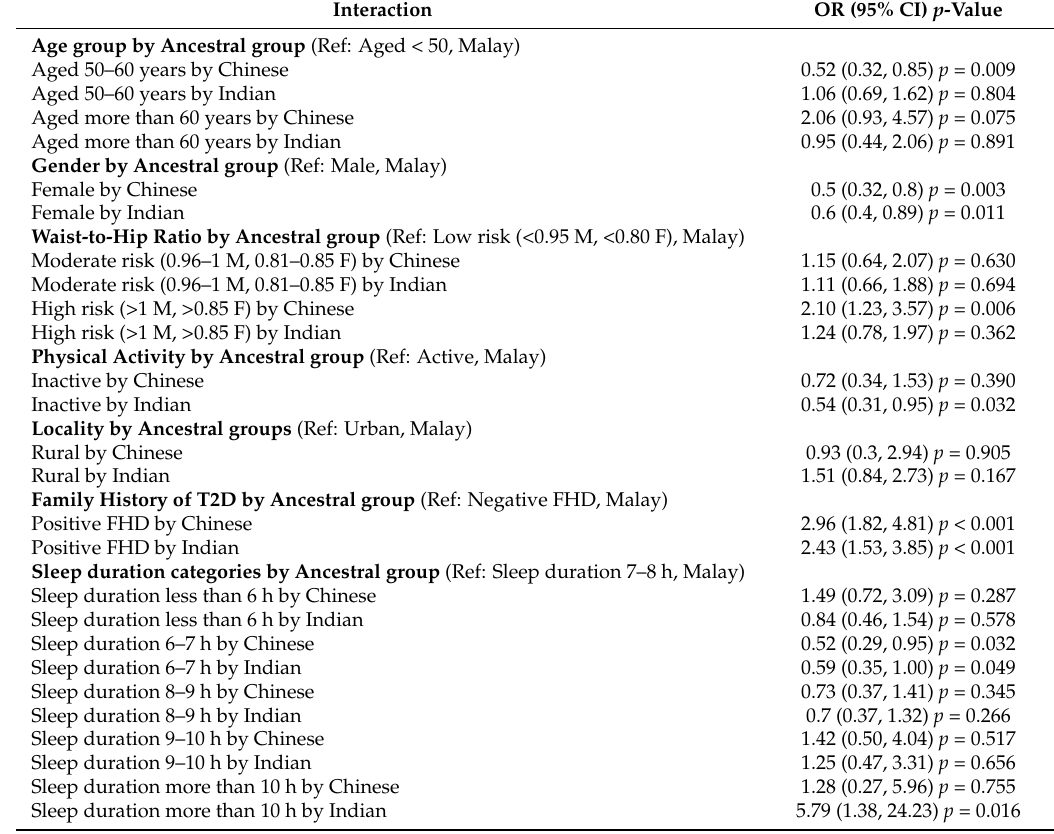
Table 5. Interaction of risk factor effects with ancestral